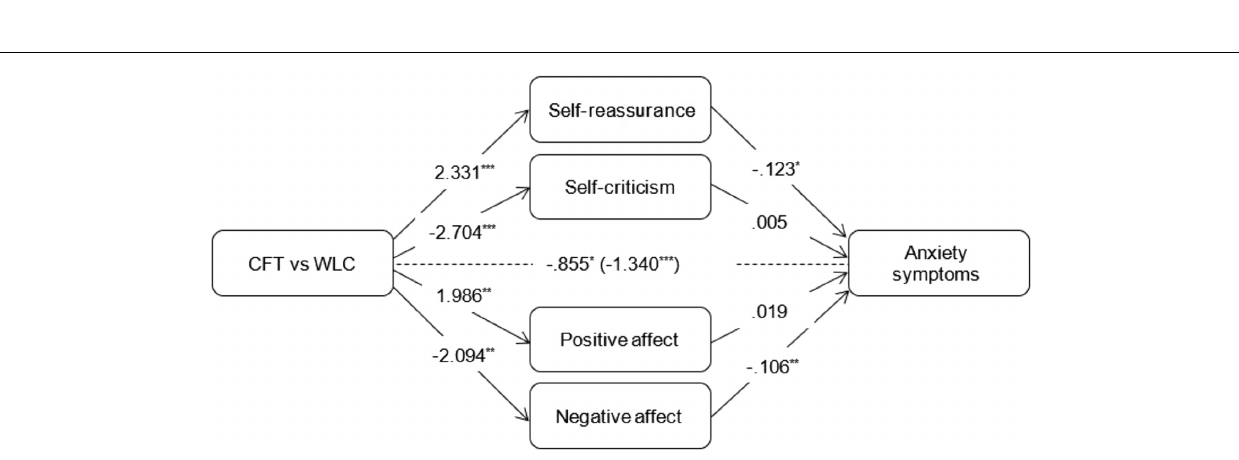
FIGURE 4 | Outcomes of multiple mediation models assessing indirect effects of mediators on changes in anxiety symptoms compared to the waitlist control condition. Total effect (c-path) is given in parentheses. ∗∗ p < 0.01 . ∗∗∗ p < 0.001.